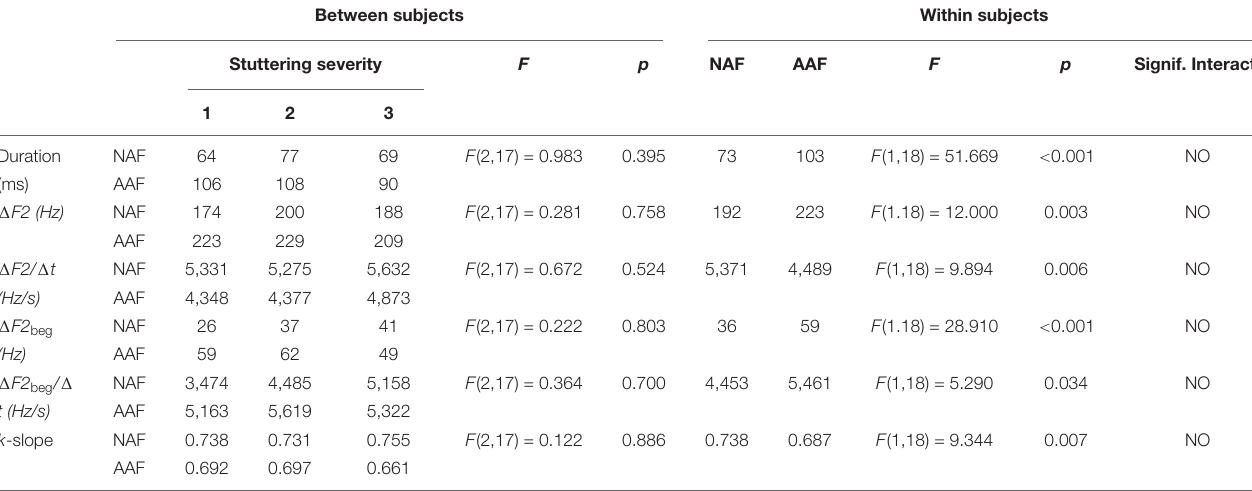
TABLE 9 | Mean values for Repeated ANOVAs on dependent variables (duration (ms), absolute values of (cid:49) F2 (Hz), of (cid:49) F2 beg (Hz) and of (cid:49) F2 beg / (cid:49) t (Hz/s), and k-slope). Between subjects Within subjects Stuttering severity F p NAF AAF F p Signif.